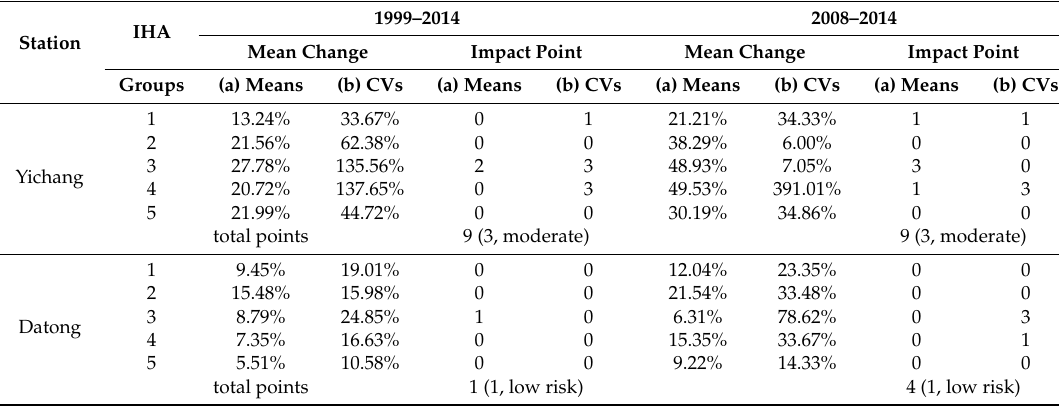
Table 6. Integrated hydrological alteration indicators for the DHRA method.